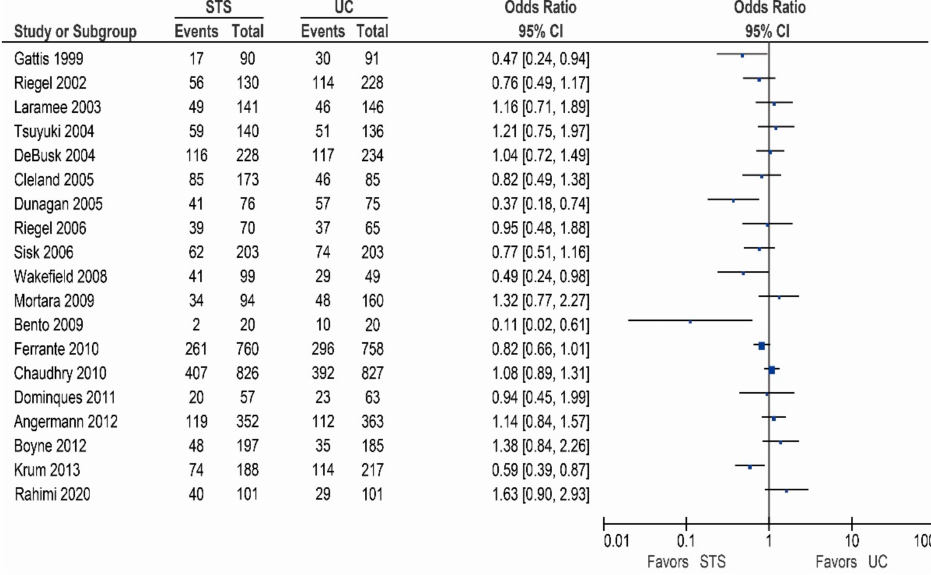
Figure 2. All-cause hospitalization in patients receiving structured telephone support versus usual care.